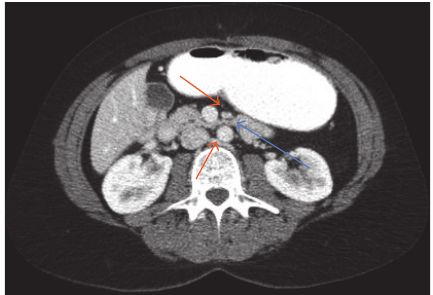
Figure 8: Duodenal compression on CT scan (blue arrow) between the aorta and superior mesenteric artery (orange arrows) (Case Report Two).